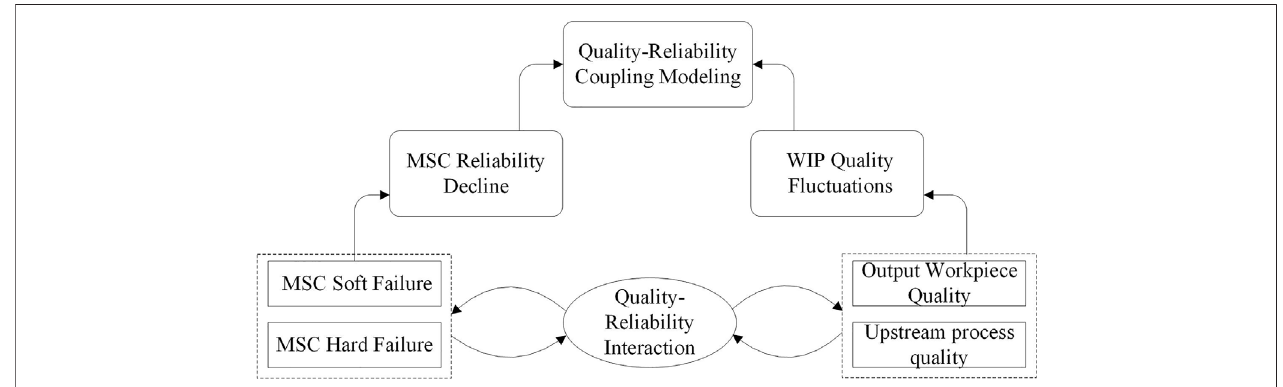
FIGURE 2 | Coupling relationship between MSC reliability and workpiece